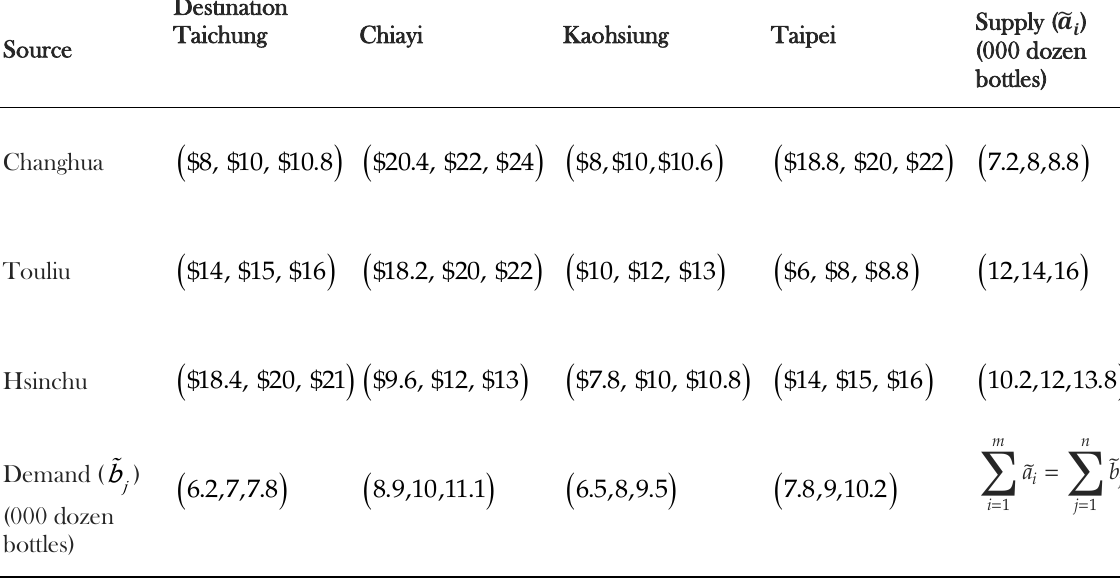
Table 4. Eq. (15) in triangular balanced form (in U.S.